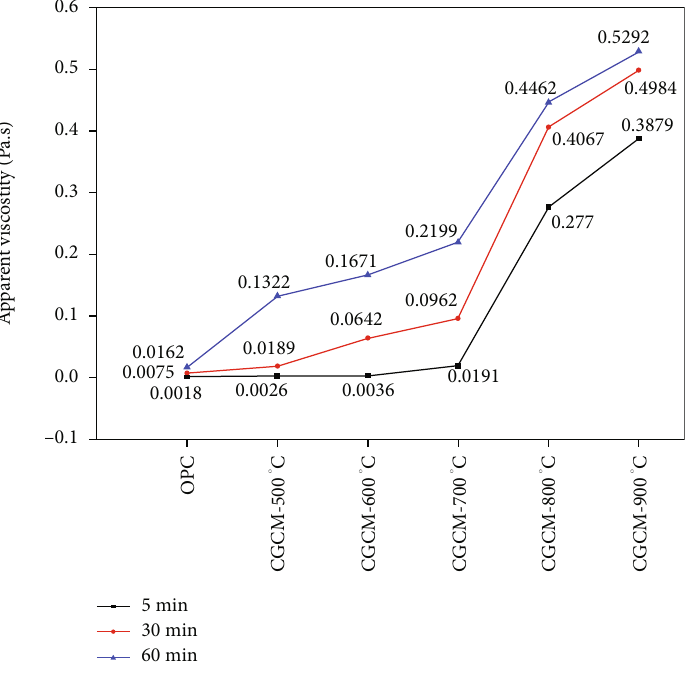
Figure 7: Plastic